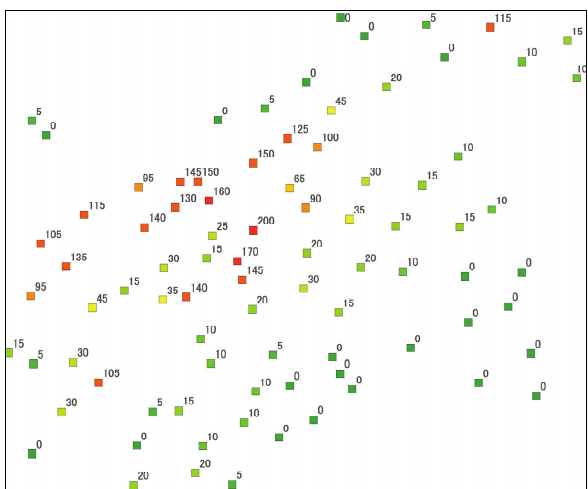
Figure 10. Flow of hydrologic analysis using